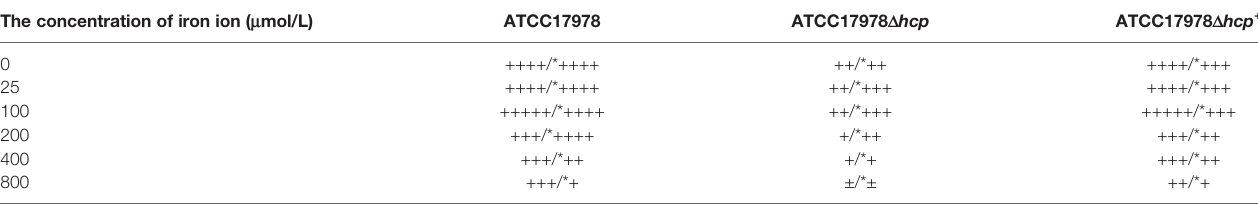
TABLE 2 | The ability of bio fi lm formation among different Acinetobacter baumannii strains and different concentrations of iron ion. The concentration of iron ion ( m